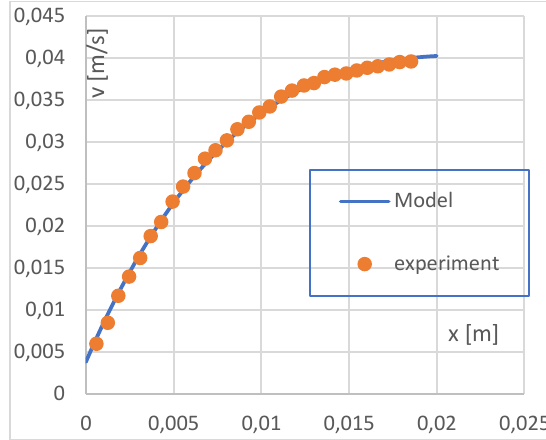
Fig. 2 Model comparison with the